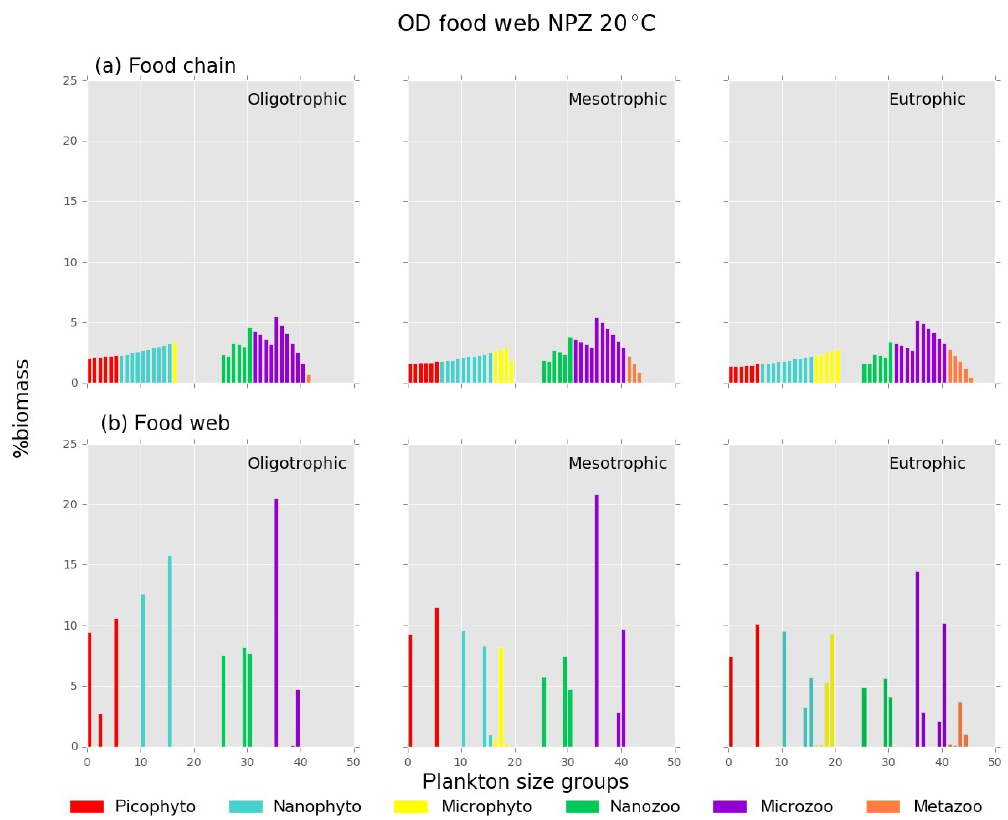
Figure B1. Relative biomass (%) of each phyto- and zooplankton group in (a) food chain and (b) food web for oligo-, meso- and eutrophic environments at 20 ◦